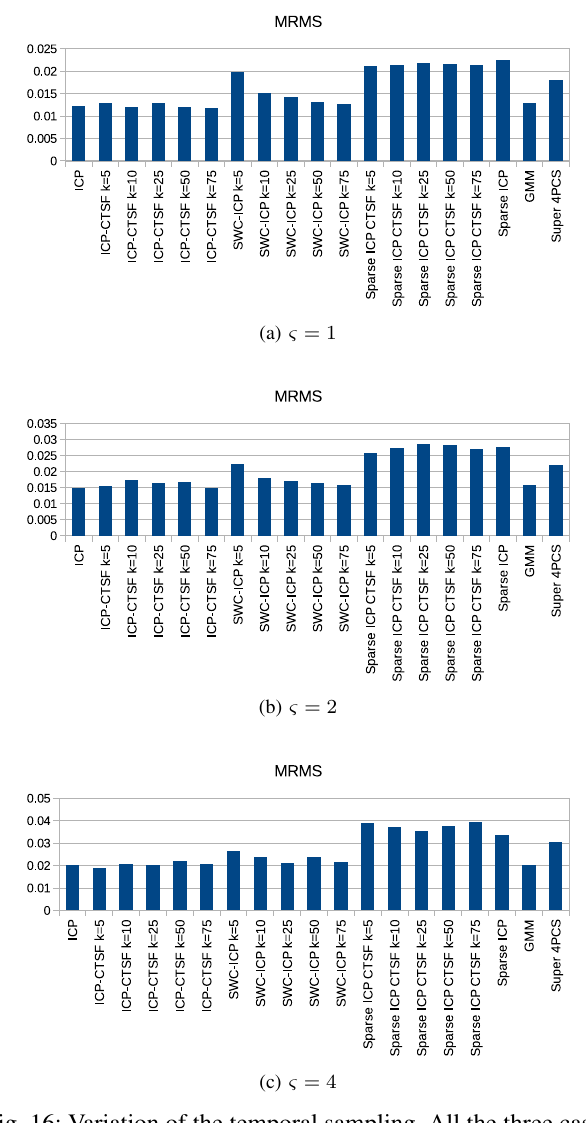
Fig. 16: Variation of the temporal sampling. All the three cases have video sampling rates r = 8 . Note how the scale changes as ς increases.